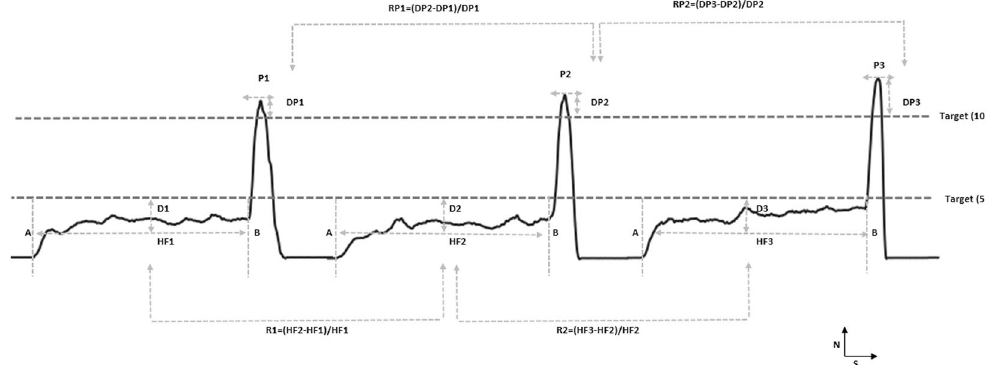
Figure 3. Examples of force profiles obtained from three consecutive trials of the behavioural task. X-axis represents the time (S) and Y-axis represents force (N). Controlled force (HF1, HF2, HF3) was defined as the average force between the times intervals from the initial contact of the teeth/digits ( A ) with the force transducer until onset of the ballistic force ( B ). The onset of the ballistic force was defined as the point at which the force rate exceeded 5N/s. The ballistic force was defined as the maximum force (P1, P2, P3) prior to the moment after which the decline in force indicated by a rapid ramp decrease in the force occurred. Accuracy: D1, D2, D3: deviation from the controlled force target (5N) and DP1, DP2, DP3: deviation from the peak force target (10N). Precision: R1, R2: relative change between trials for hold force and RP1, RP2: relative changes between trials for peak force.